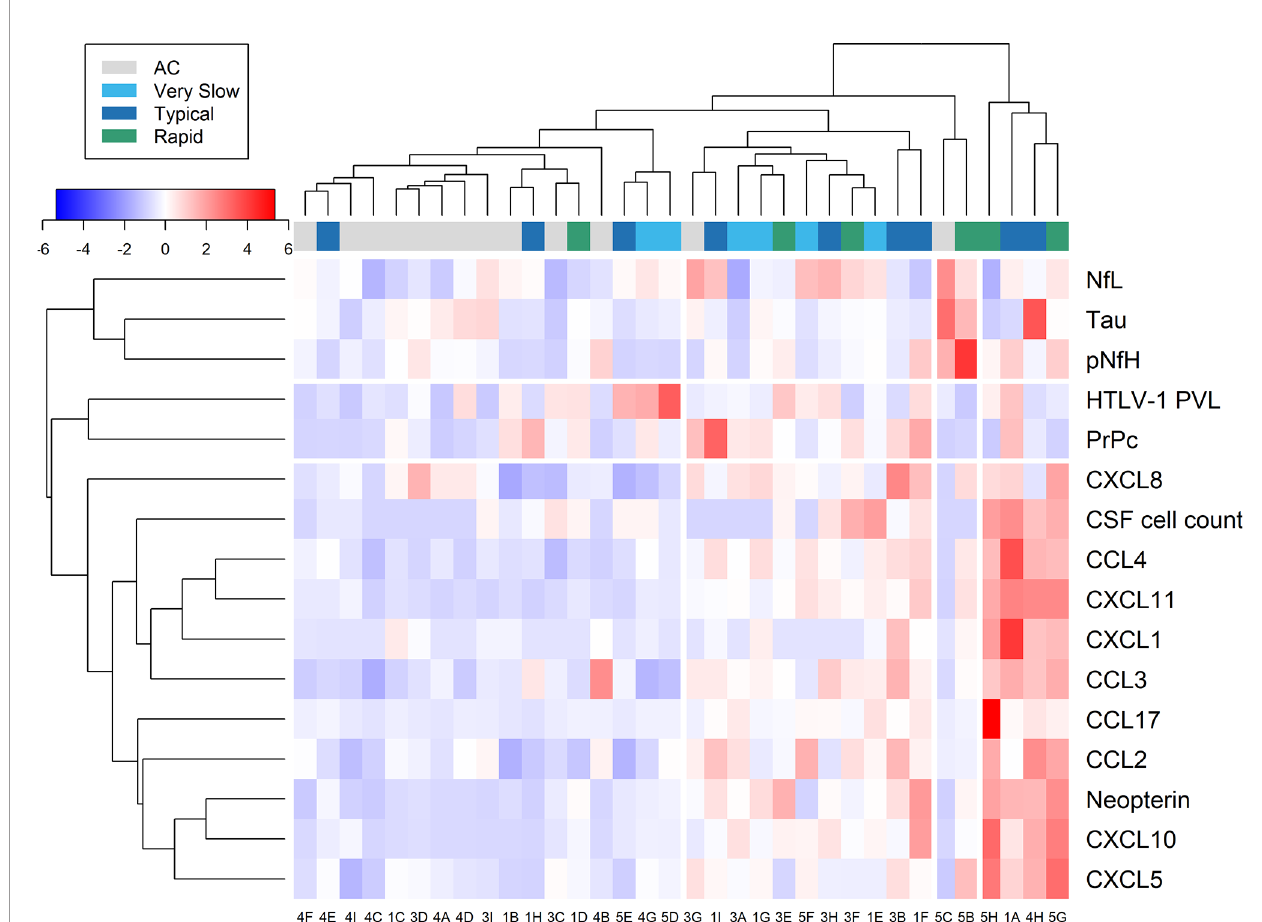
FIGURE 9 | Relative expression of markers of neuroin fl ammation and neuronal injury. Data from cerebrospinal fl uid (CSF) analysis of HTLV-1 asymptomatic carriers (AC) and HAM/TSP patients identi fi ed with very slow (light blue), typical (dark blue), and rapid (green) disease progression were evaluated by heatmap analysis. This included CSF cell counts, HTLV-1 proviral load (PVL), and the concentration of neuro fi lament light (NfL) and phosphorylated heavy (pNfH) chains, total Tau protein, cellular prion protein (PrPc), neopterin, and in fl ammatory chemokines (CCL2, CCL3, CCL4, CCL17, CXCL1, CXCL5, CXCL8, CXCL10,